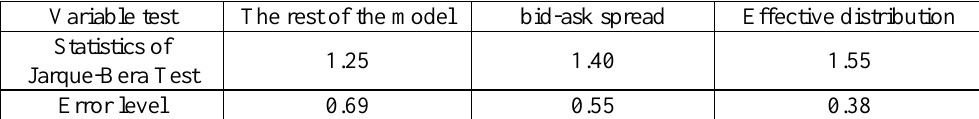
Table 6. Results of the normality test of the research dependent variable and Error Term Variable